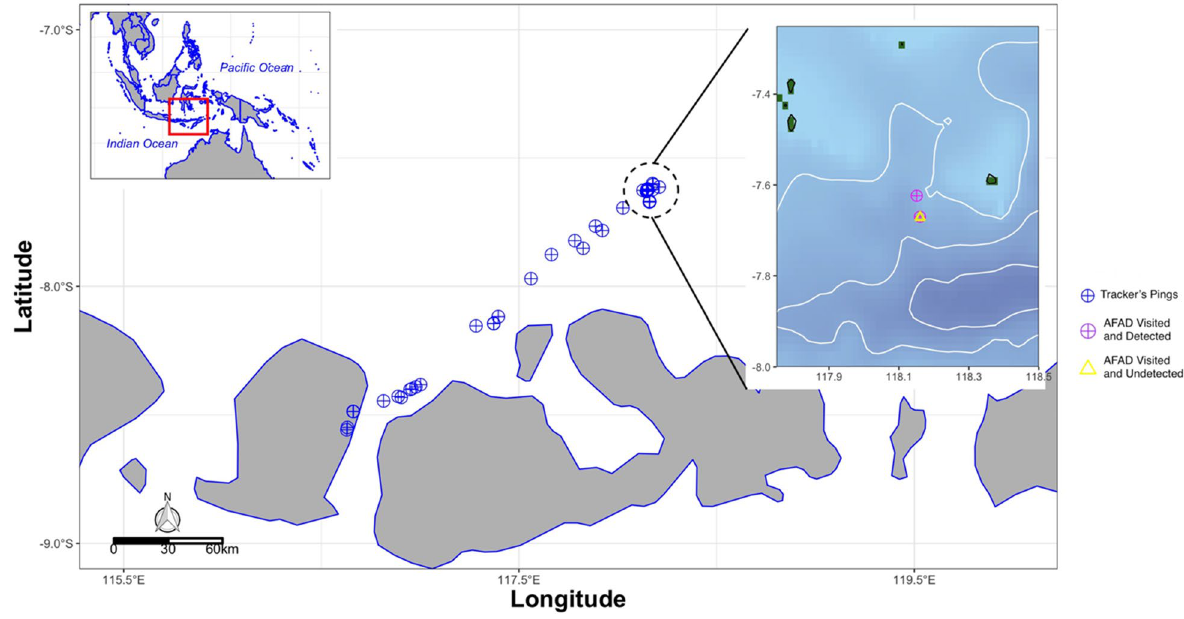
Figure 2. The full record from the SPOT Trace tracking device onboard the vessel, and AFADs visited and analysed by using DBSCAN. Map made using R version 4.0.3 36 by utilizing marmap 37 and ggmap package 38 with bathymetry data extracted from ETOPO1 1 Arc-Minute Global Relief Model 39 .